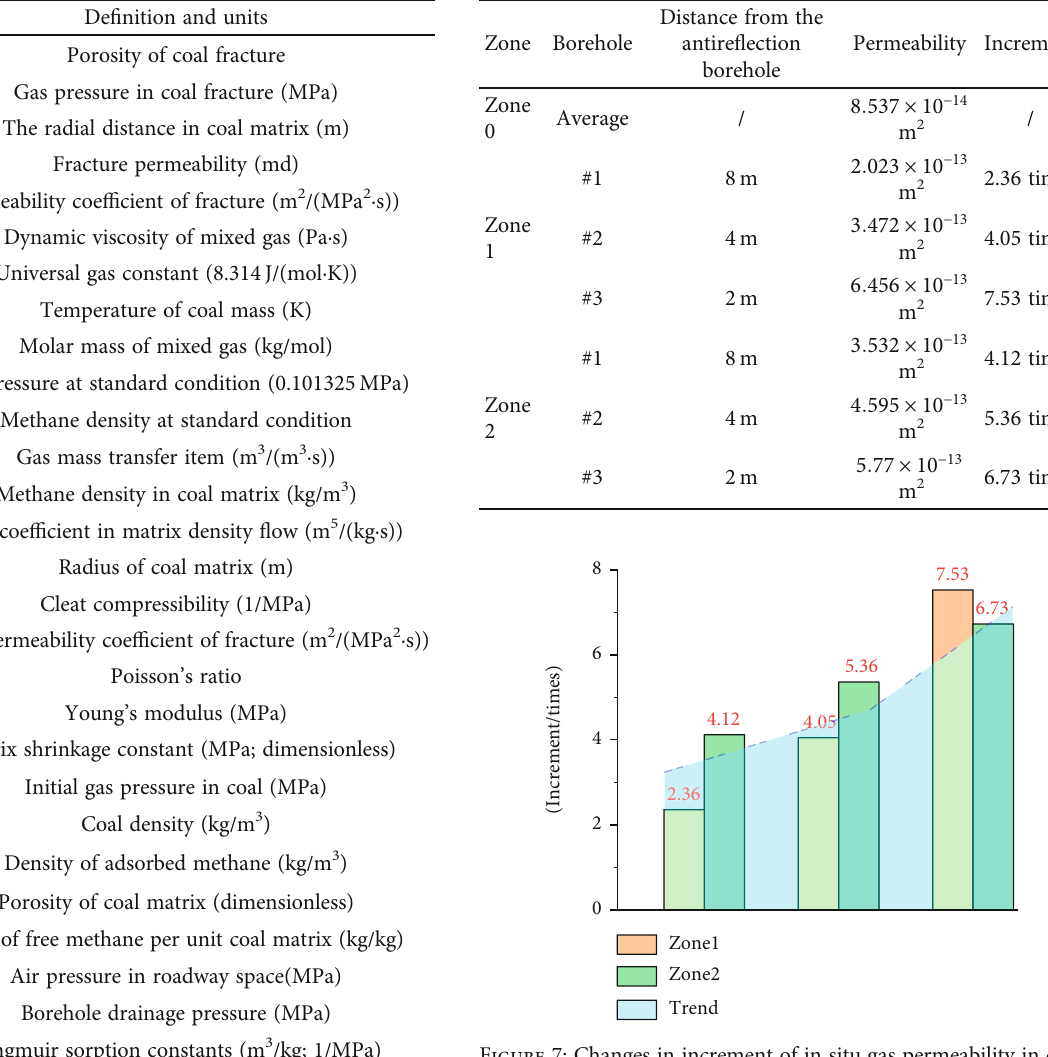
Table 4: List of symbols. Table 5: Result of gas permeability